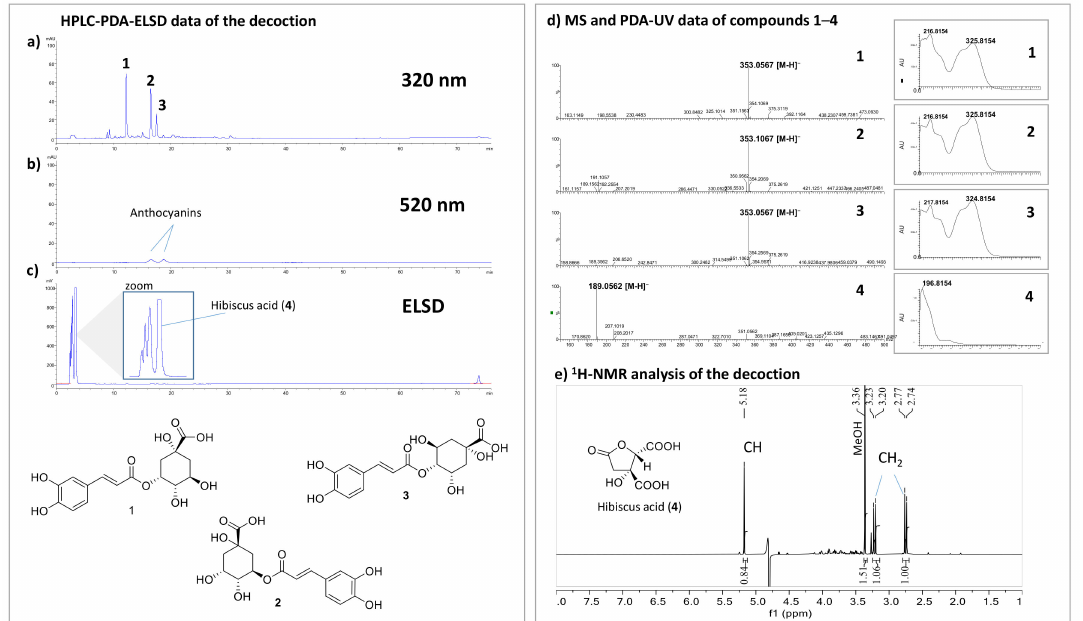
Figure 3. HPLC-PDA-ELSD analysis of HS decoction: ( a ) PDA detection at 320 nm; ( b ) PDA detection at 520 nm; ( c ) ELSD detection. UHPLC-PDA-MS analysis ( d ); MS and UV spectrum of compounds 1–3; ( e ) 1H-NMR analysis of HS decoction in a deuterated phosphate buffer (pH 7) containing 0.9 mM of TSP (sodium trimethylsilyl propionate). The signals of hibiscus acid (4) are